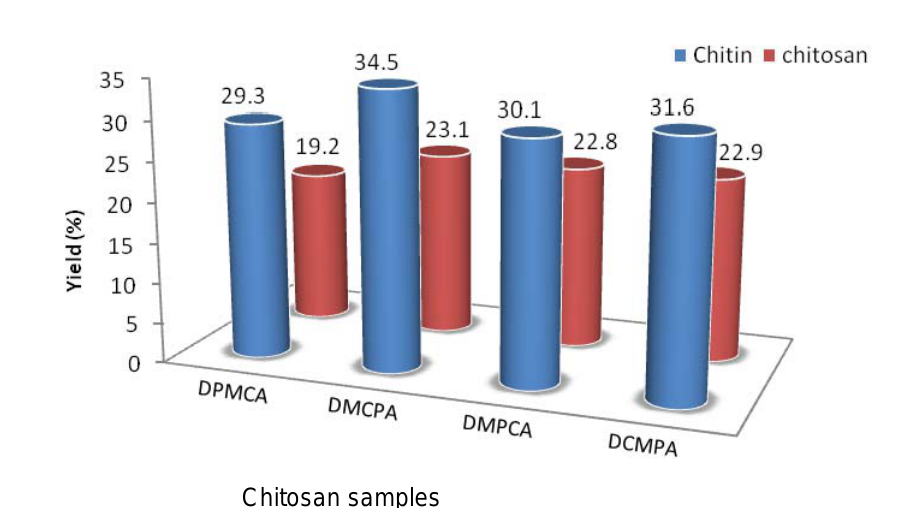
Figure 1 .Chitin and chitosan production yield from A. urmiana cyst